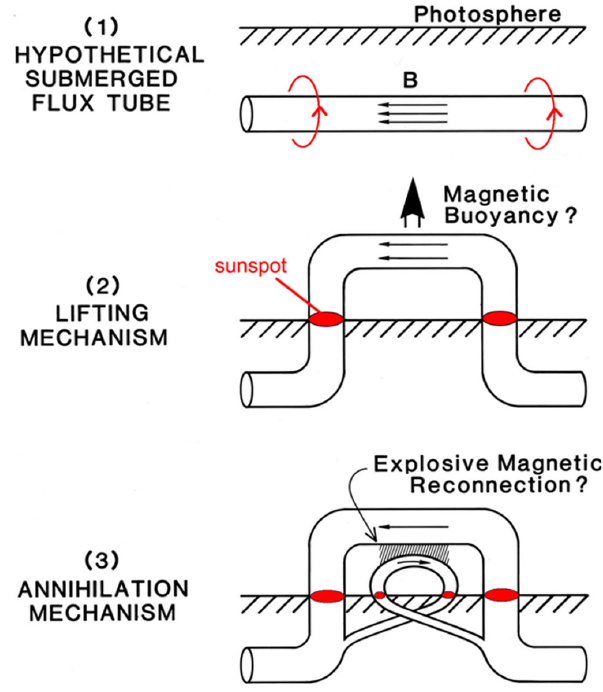
Fig. 1b. Schematic illustration of how a tube of magnetic flux forms a sunspot pair, and how a solar flare is supposed to occur by mag- netic reconnection. In the top diagram, the red circles represent the solenoidal